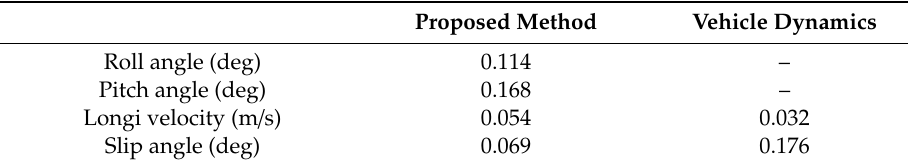
Table 3. Root mean square (RMS) of estimation errors in DLC maneuver.